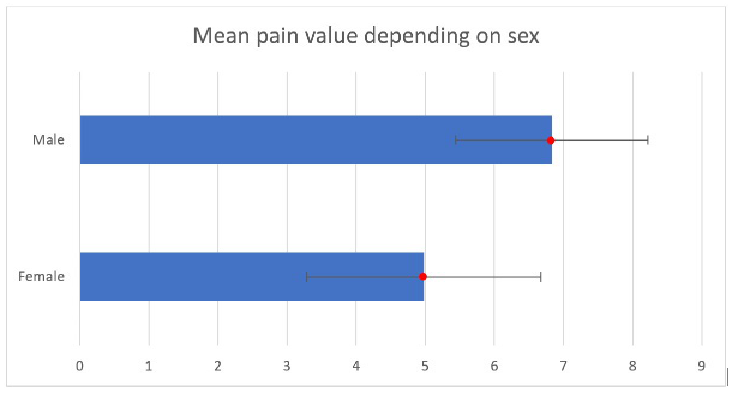
Figure 5. Graphical representation of pain value depending on sex.